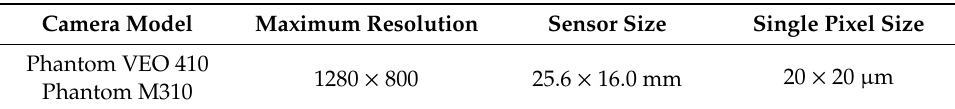
Table 1. Parameters of the two high-speed